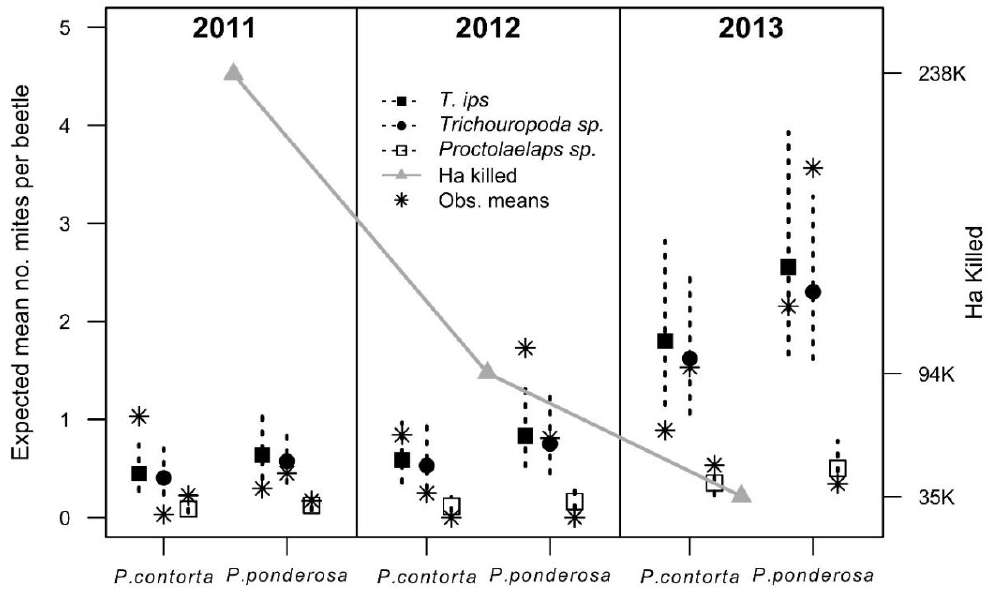
Figure 2. The expected mean mite load on the mountain pine beetles (MPB) attacking P. ponderosa and P. contorta from 2011 to 2013. There was an increasing trend in MPB mite load that was inverse to a decreasing MPB population trend (gray line) in Larimer County, CO (USDA FHT, online). See